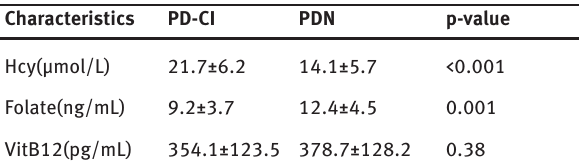
Table 2: The comparison of serum Hcy, folate, VitB12 between PD-CI and PDN